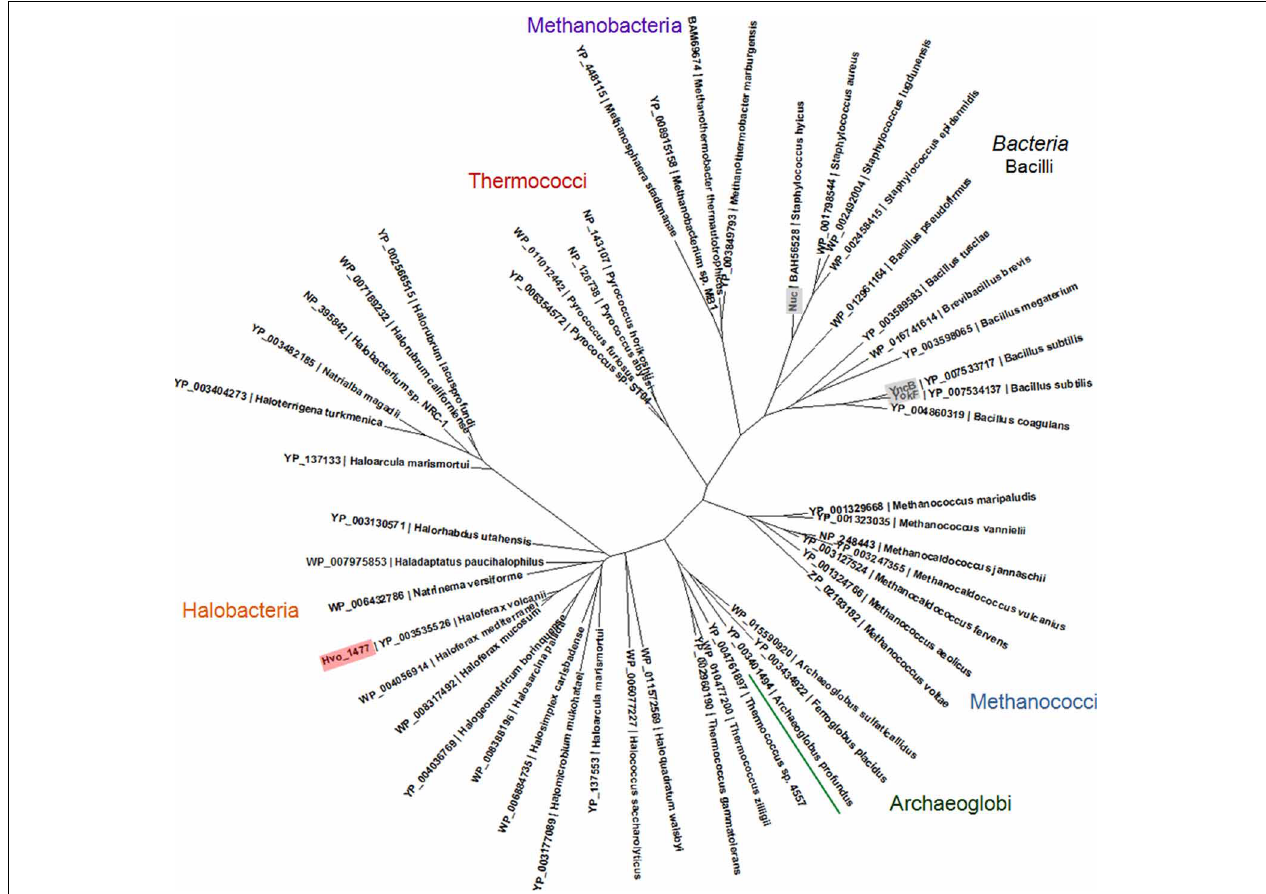
FIGURE 9 | Phylogenetic tree of archaeal YokF/Nuc protein homologs. A protein alignment was created with Clustal Omega (Sievers et al., 2011) and used to create a maximum likelihood tree using PhyML (Guindon and Gascuel, 2003). Proteins included in alignment were identified in a BLASTP